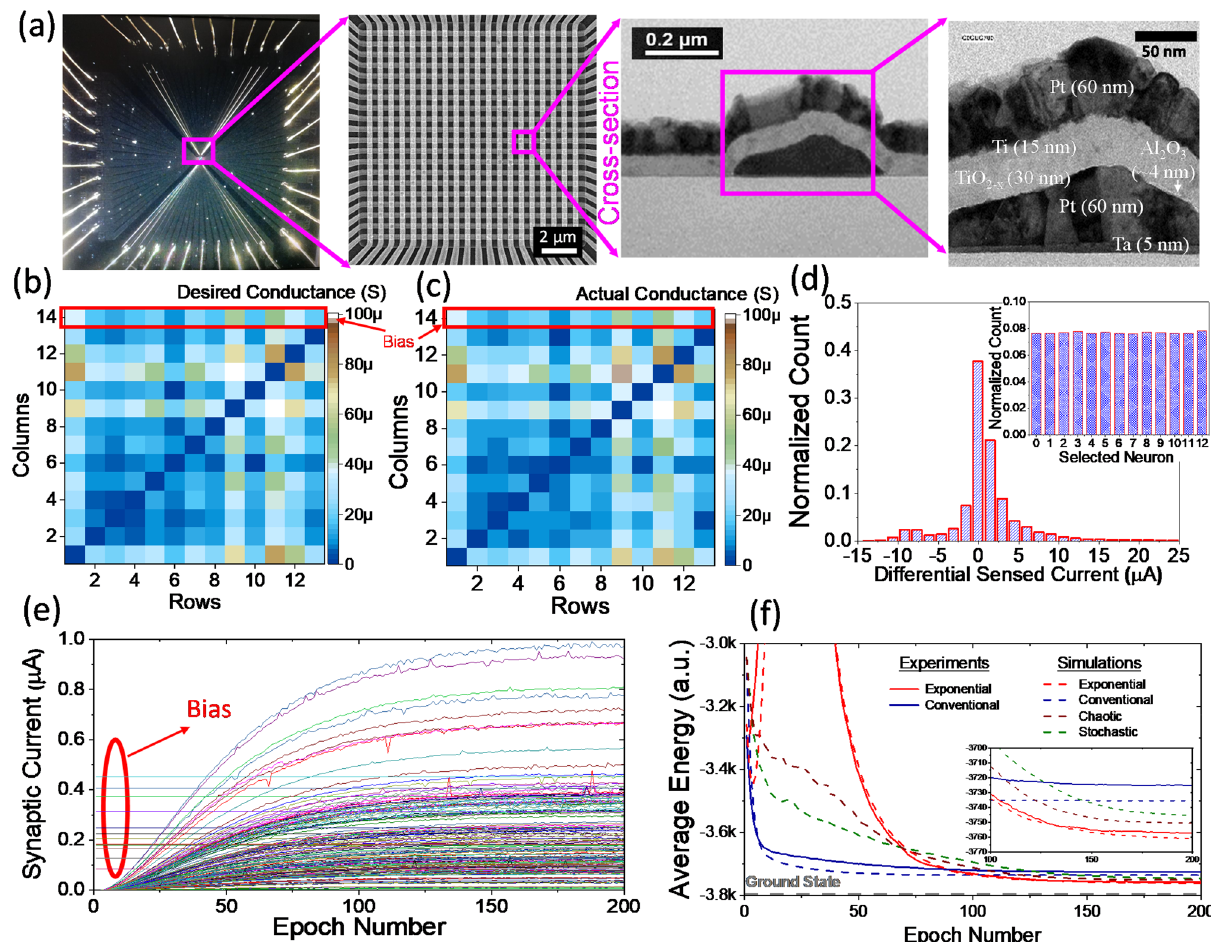
Figure 3. The experimental demonstration with the integrated memristor crossbars. ( a ) The fabricated 20 × 20 integrated memristor crossbar 29 . ( b ) The desired ideal analog map for the 13-node graph partitioning problem, and ( c ) the resultant conductance map of the devices after tuning the crossbar. ( d ) Distribution of the readout current when solving the problem with the conventional (baseline) approach. The inset shows the histogram of selected neurons (for updates) and indicates there is no bias in the neuron update. ( e ) The evolution of the synaptic weights during the weight annealing. ( f ) The experimental versus simulation results of the neuro- optimization with different techniques. The inset shows the zoomed-in average energy in the last 100